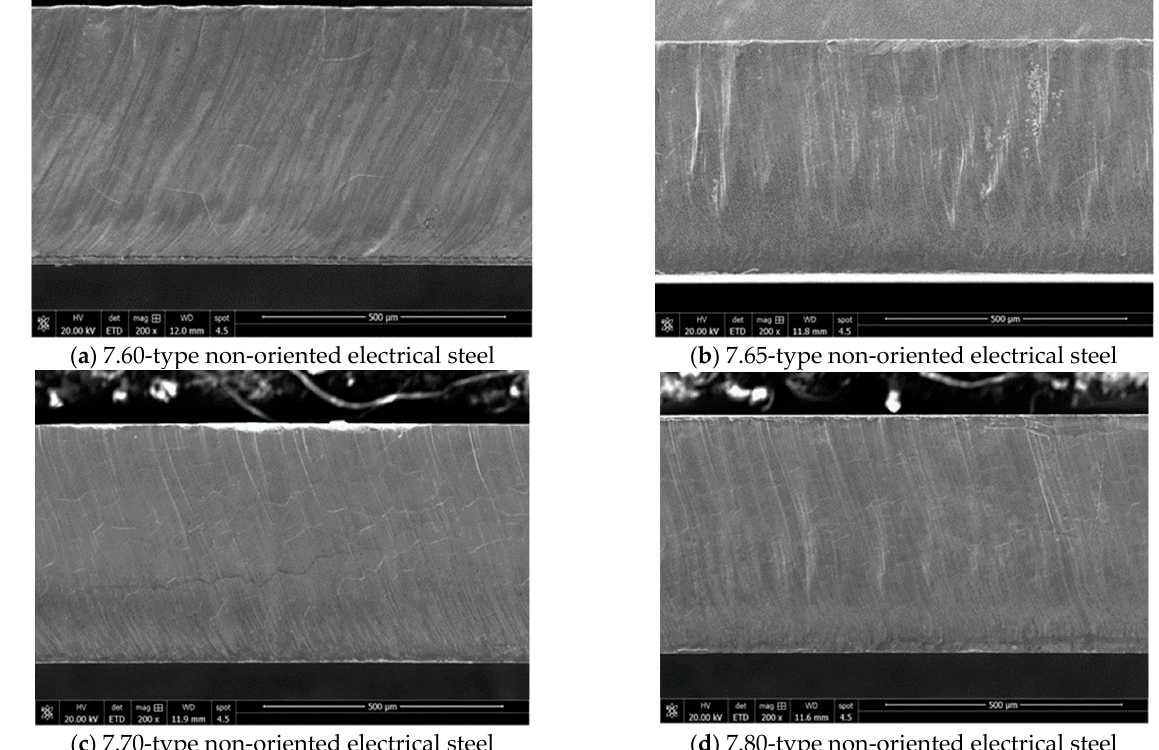
Figure 10. SEM micrographs of cut edge of the non-oriented electrical steels cut under the same process parameters. process